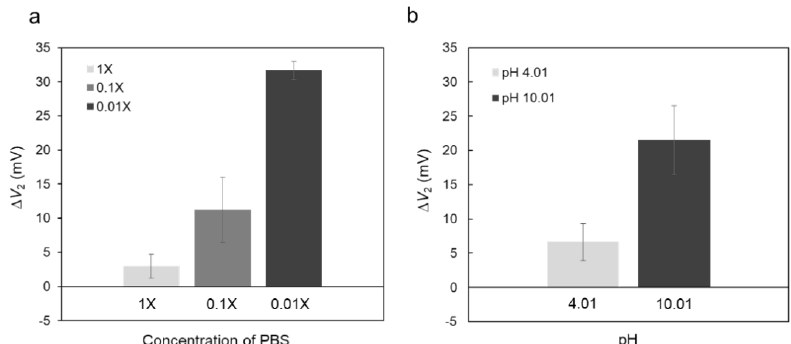
Figure 4. The effect of the electrolyte solution used for the electrical measurement on the electrical signal of the MCC-based ISFET sensor. ( a ) Δ V 2 at different ionic strengths. 0.01X, 0.1X, and 1X PBS solutions were used as the measurement solutions. Each signal was averaged over three measurements (n = 3) with the standard deviation shown as error bars; ( b ) Δ V 2 for different pHs. pHs 4.01 and 10.01 buffer solutions were used for the measurement solutions. Each signal was averaged over three measurements (n = 3) with the standard deviation shown as error bars.